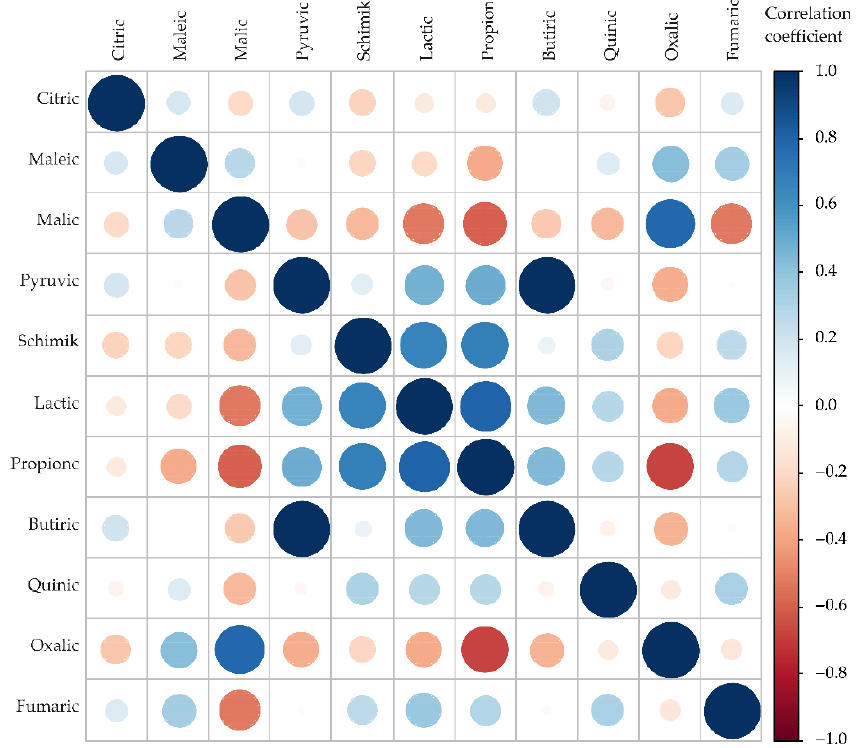
Figure A2. Color correlation graph between metal contents in raspberry extract samples.